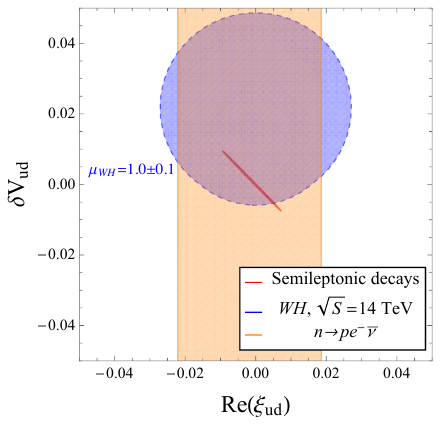
Figure 12 . The (cid:12)gure shows the constraints in the (cid:24) ud (cid:0) (cid:14)V ud plane, after marginalizing over (cid:24) us and (cid:14)V us . The blue line depicts the constraint from WH production, while the red line indicates the limits from superallowed (cid:12) decay and leptonic pion decay. The vertical orange band results from the experimental determination of (cid:21) , from neutron decay correlations, in combination with an assumed lattice determination of g A = 1 : 27 (cid:6) 0 :